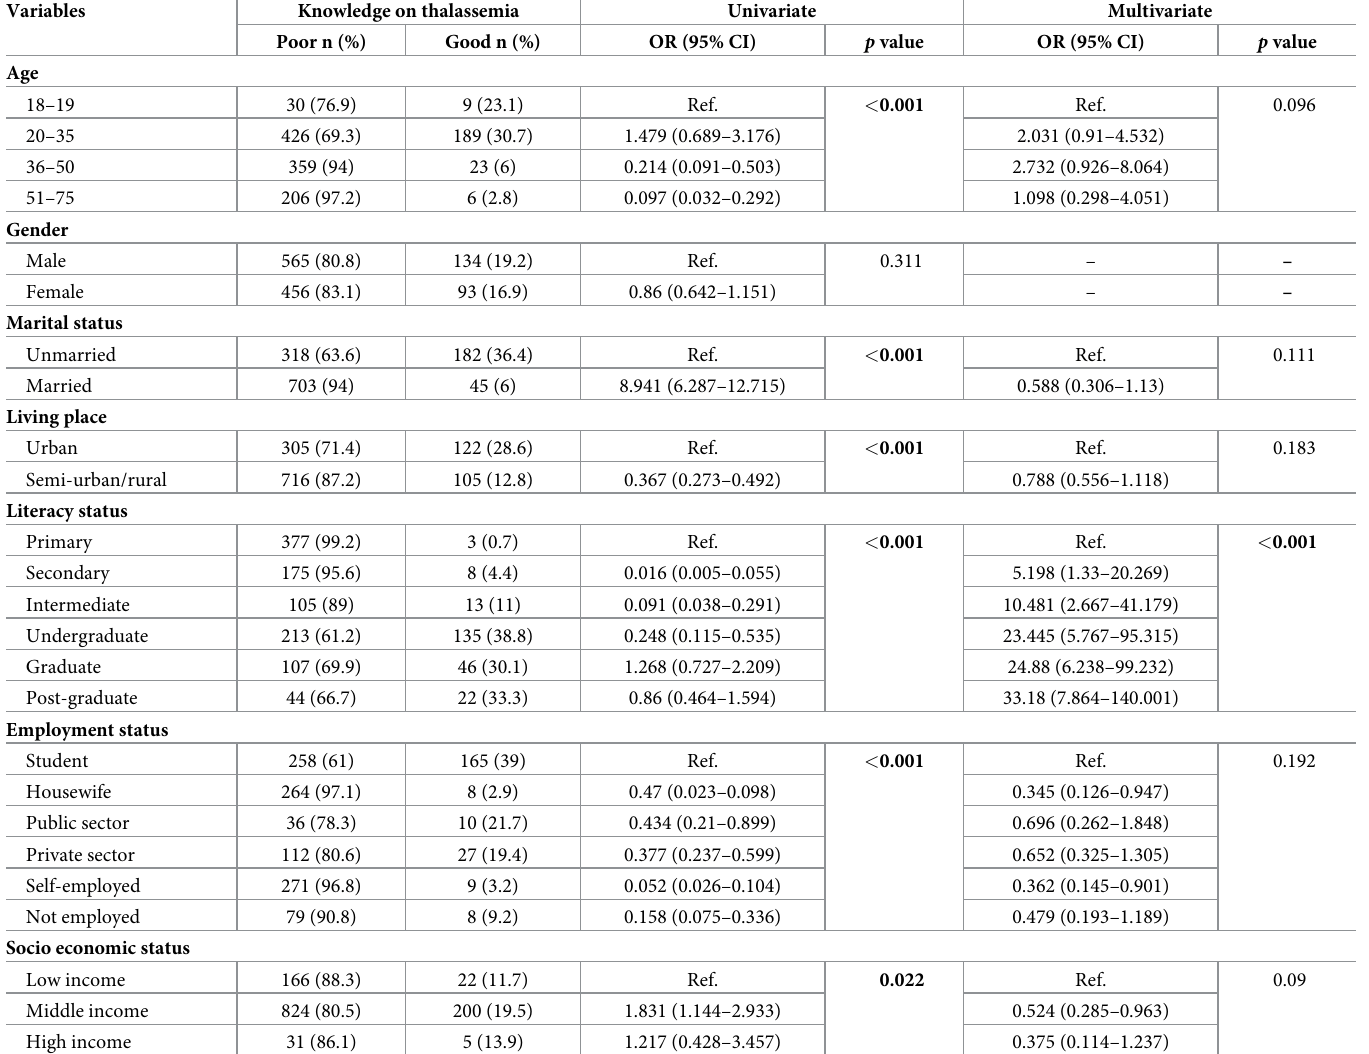
Table 4. Univariate and multivariate analyses of factors associated with knowledge on thalassemia (n = 1,248).